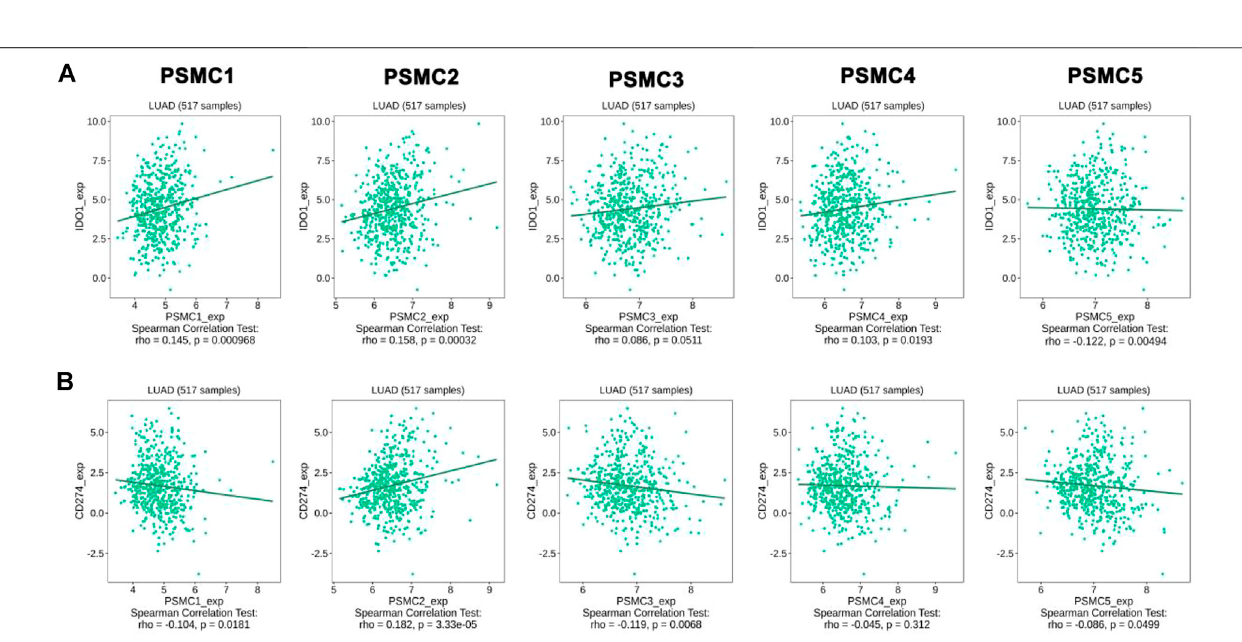
Frontiers in Genetics | www.frontiersin.org July 2022 | Volume 13 | Article 935286